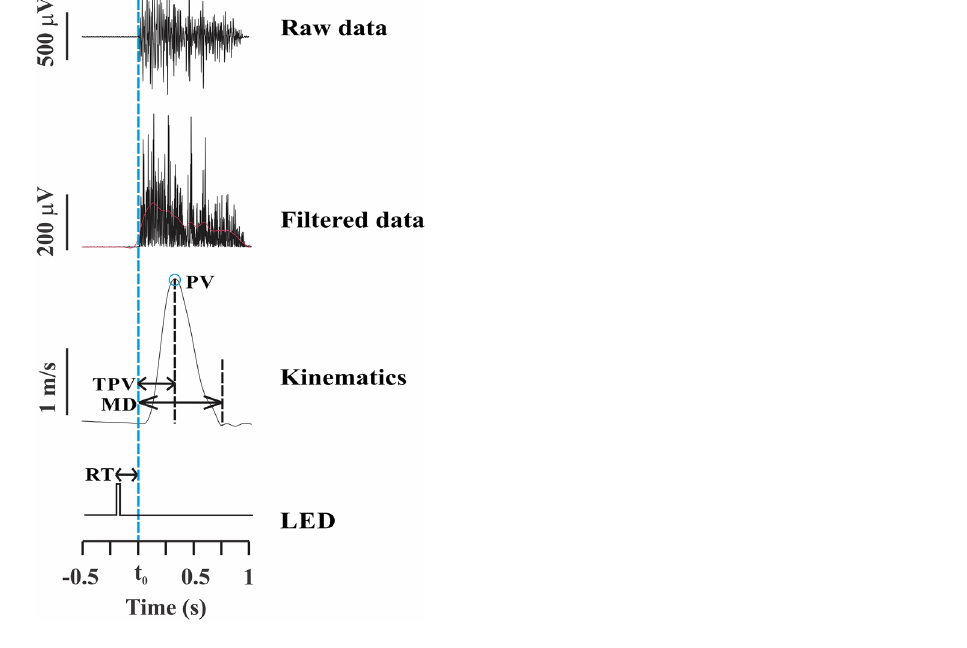
Figure 2. DEL onset detection after LED stimuli and using kinematic parameters. Dashed blue line represents T 0 moment of the